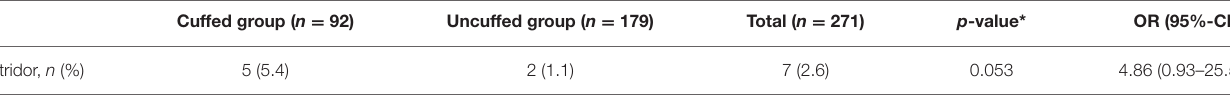
TABLE 2 | Post-extubation stridor in patients being intubated with cuffed or uncuffed endotracheal tubes. Cuffed group ( n =